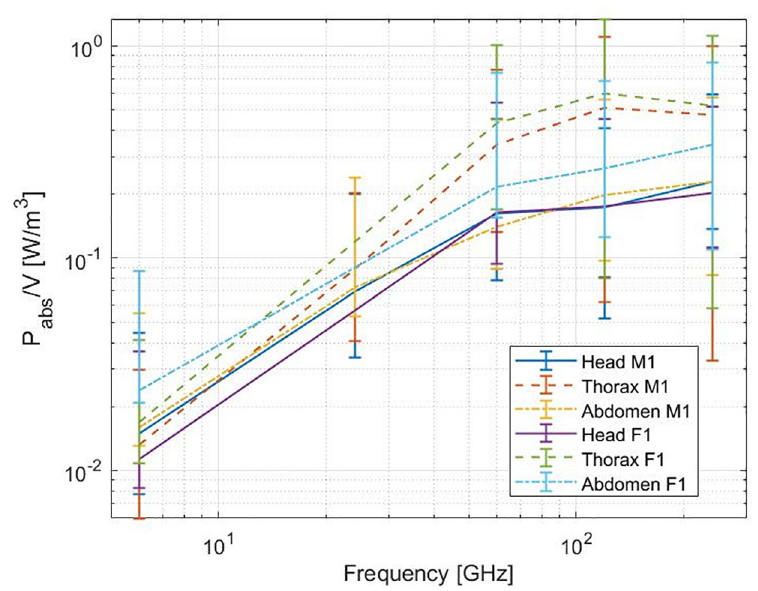
Fig 6. Averaged absorbed power as function of frequency in the head, thorax, and abdomen of a yellow fever mosquito For an incident field strength of 1 V/m. Averaged over the volumes of the body part for mosquitoes M1 and